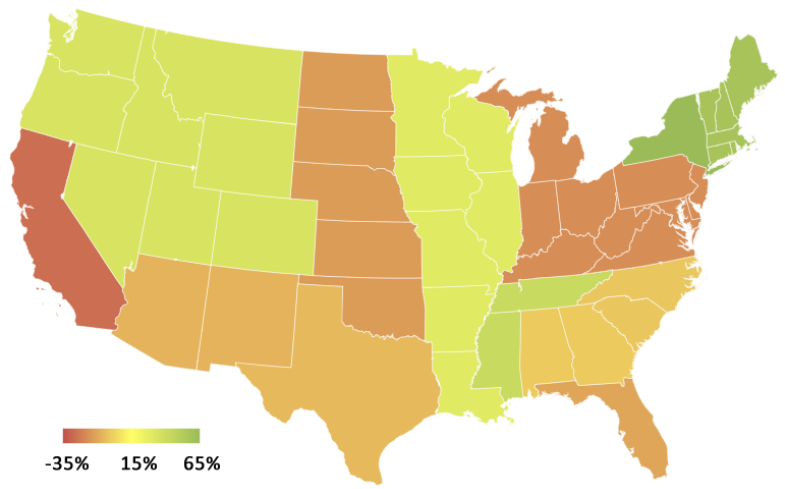
Figure 11. Correlation between the charging and RES profiles in